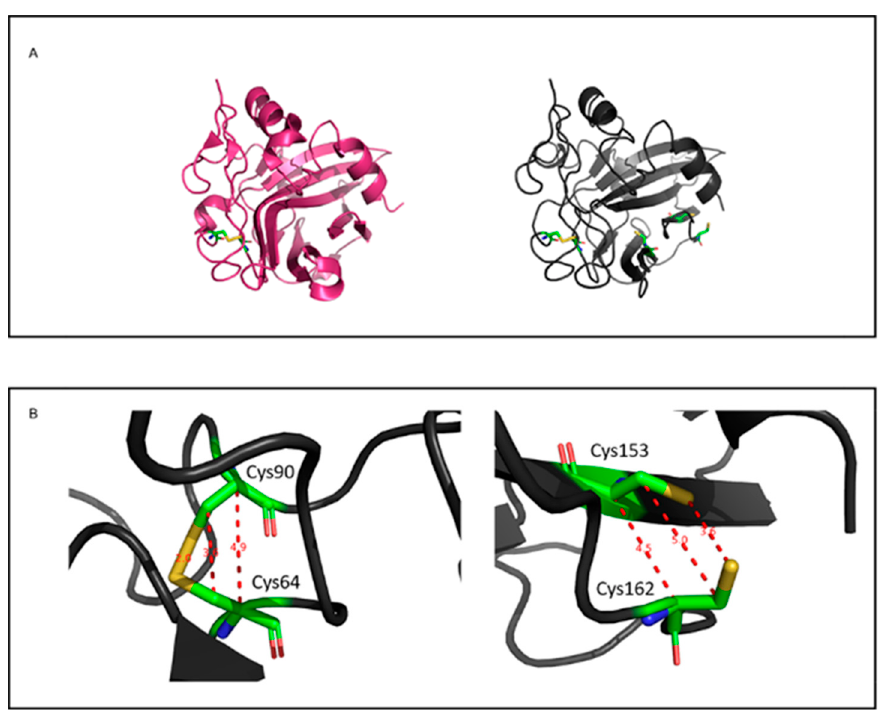
Figure 2. Analysis of potential disulfide bonds in PeNLP1. ( A ) Predicted 3D structures of template (PDB 3ST1) and target (NLP-1 modeled using SWISS-MODEL) in pink and gray, respectively. Cysteine residues are shown in sticks, colored by atoms (carbon in green, oxygen in red, nitrogen in blue and sulfur in yellow). ( B ) Distances between carbon- α , carbon- β and sulfur atoms of cysteine residues in the model structure of NLP-1. The figures were generated using Pymol.